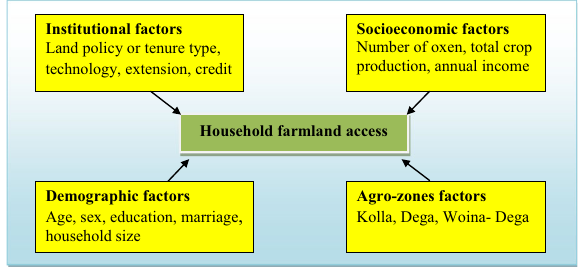
Fig. 1 The Schematic diagram of variables of household farmland access. Schematic diagram of variables showing the dependent variable (Green) and the predictor variables categorized as institutional, demographic, socioeconomic and physical factors (Yellow).